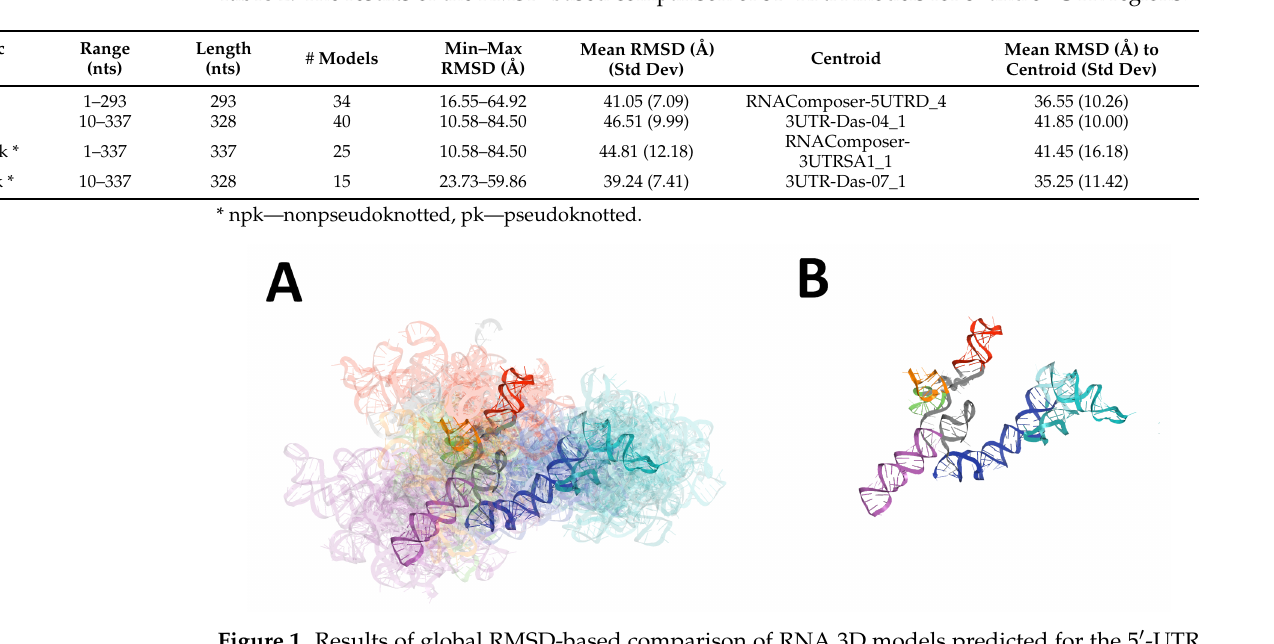
Table 2. The results of the RMSD-based comparison of 3D RNA models for 3 (cid:48) and 5 (cid:48) -UTR regions.